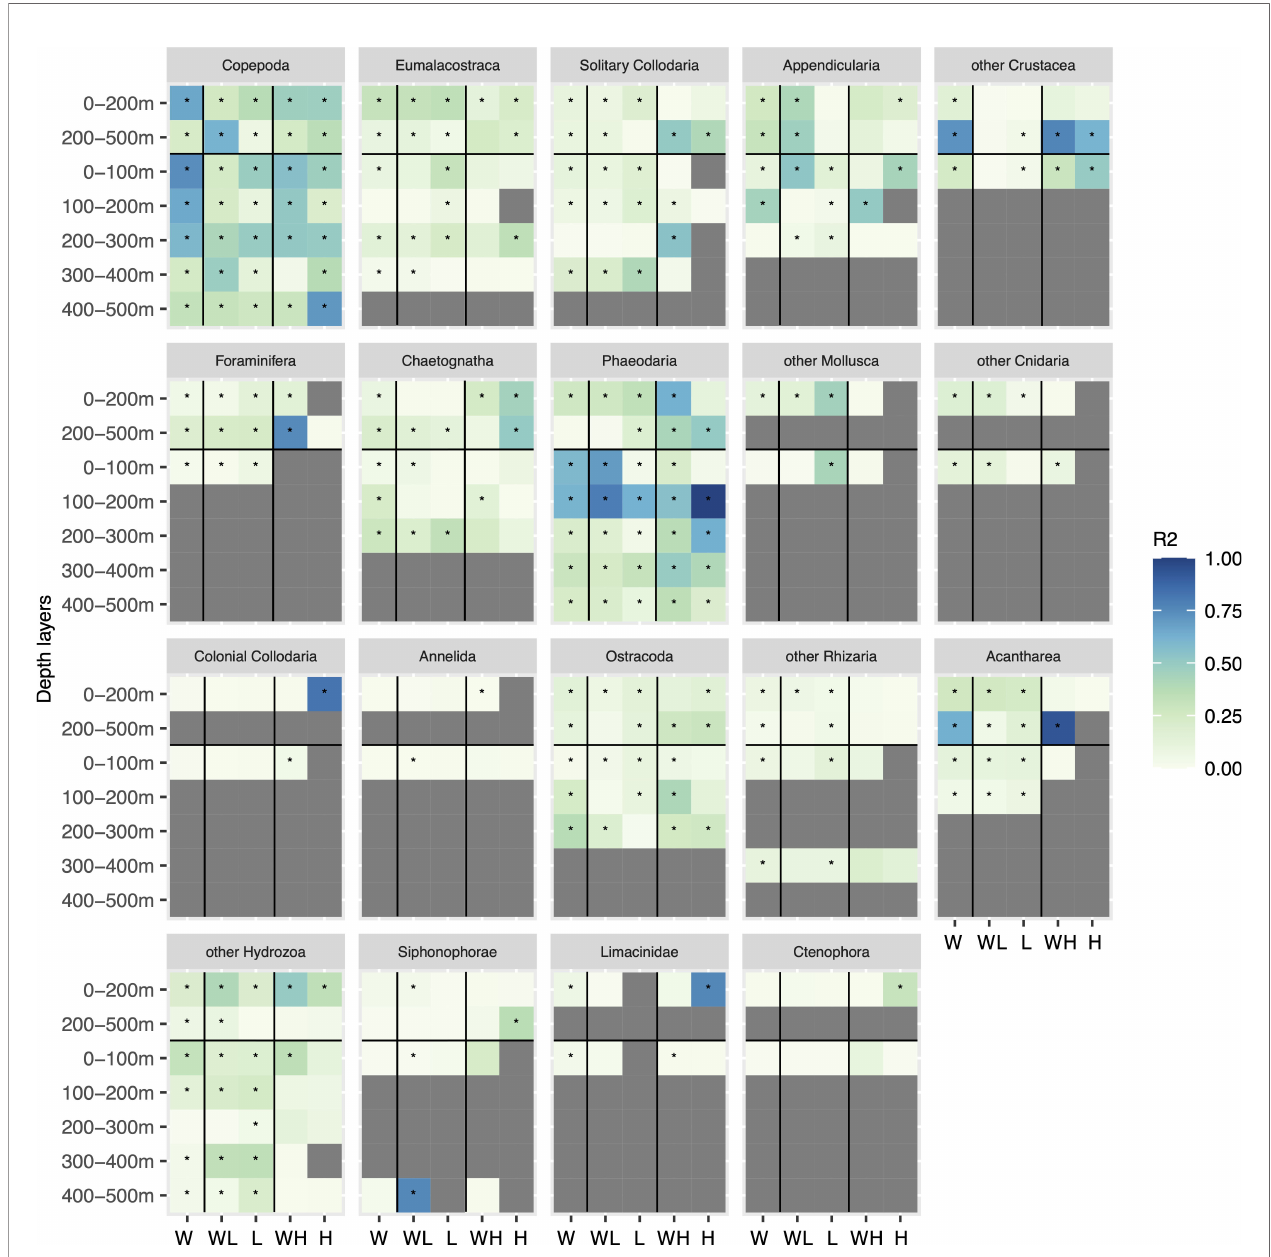
FIGURE 3 | Heatmap of the models ’ R 2 between observed and predicted biomass for all zooplankton groups arranged from the most important in terms of biomass (Copepoda) to the least important (Limacinidae) in the different depth layers. The regions correspond to: W for world (model run on all data); WL for world low (data between 40°N and 40°S from the world model); L for low latitude (model run between 40°N and 40°S); WH for world high (data outside of 40N and 40S from the world model); H for high latitude (model run outside of 40°N and 40°S). The stars indicate signi fi cant results (p-value < 0.05) obtained with the Pearson correlation